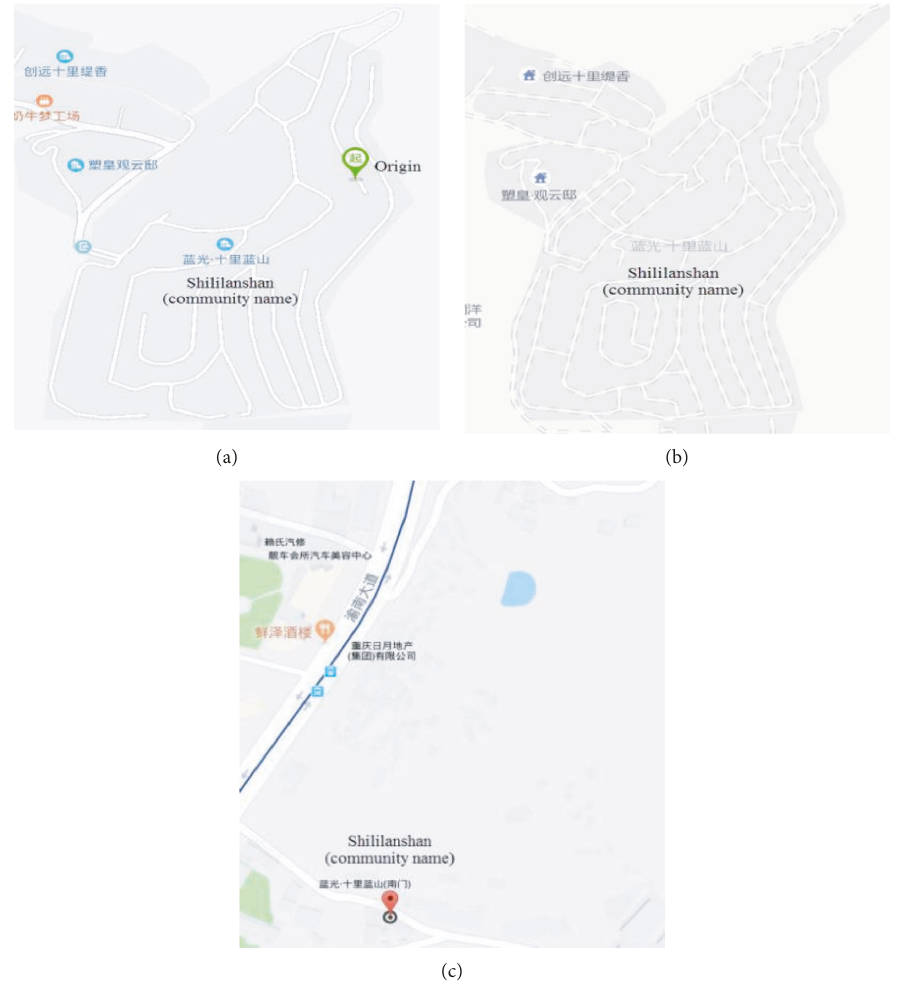
Figure 6: Road conditions on different maps of a residential area in Chongqing. (a) Baidu Maps, (b) Amap (AutoNavi Map), and (c) Google